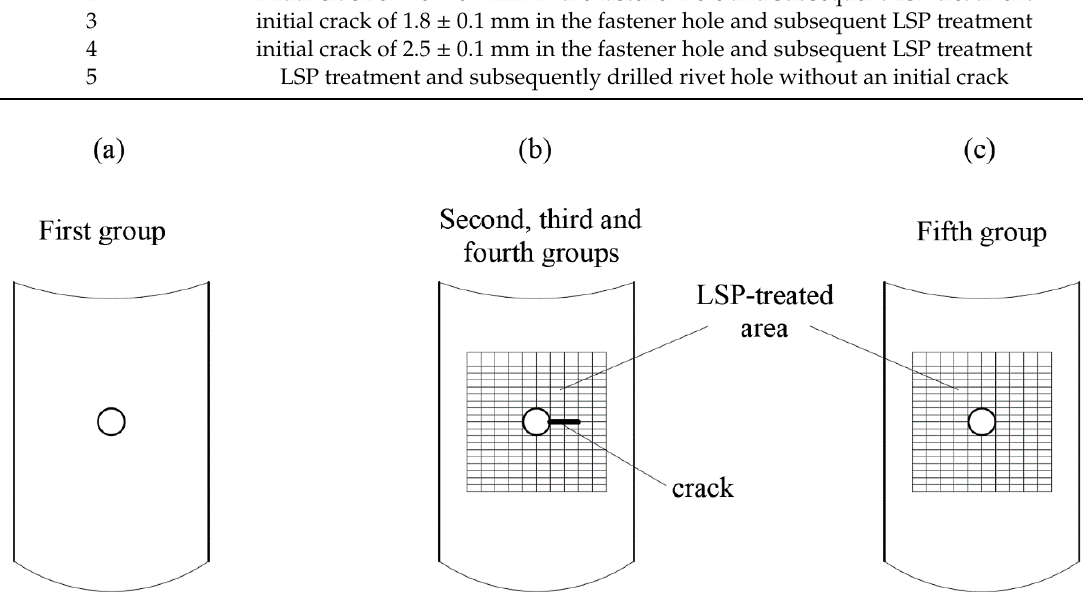
Figure 2. ( a ) Illustration of the base material specimens, including a fastener hole; ( b ) Illustration of the specimens from the 2 nd , 3 rd , and 4 th groups, including a fastener hole and an initial crack, which are subsequently treated by LSP; ( c ) Illustration of the specimens from the 5 th group, where the specimens are first treated by LSP before a fastener hole is introduced.